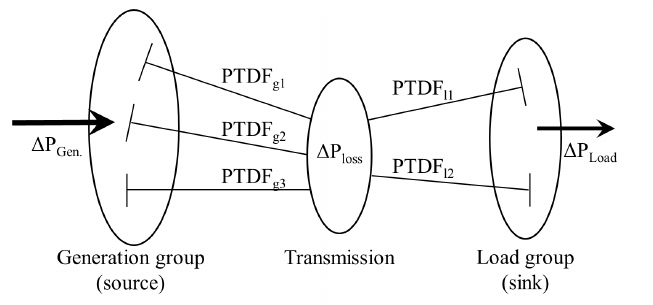
Figure 2. AC-PTDF with power injection at source and power withdrawal at sink.